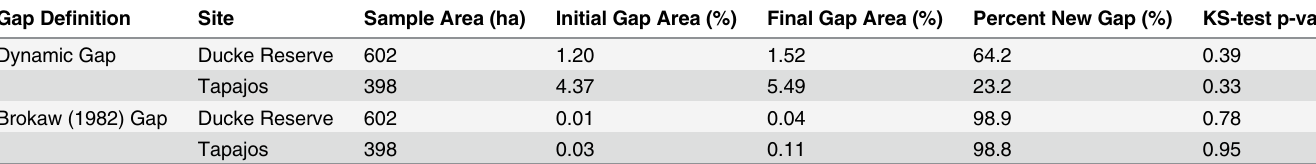
The area covered by lidar at both time periods is reported with the proportion of initial gap area, proportion of fi nal gap area, and the proportion of the amount of fi nal gap area newly formed between samples for both the dynamic gap de fi nition (10 m height cutoff) and the Brokaw (1982) gap de fi nition (2 site by de fi nition.